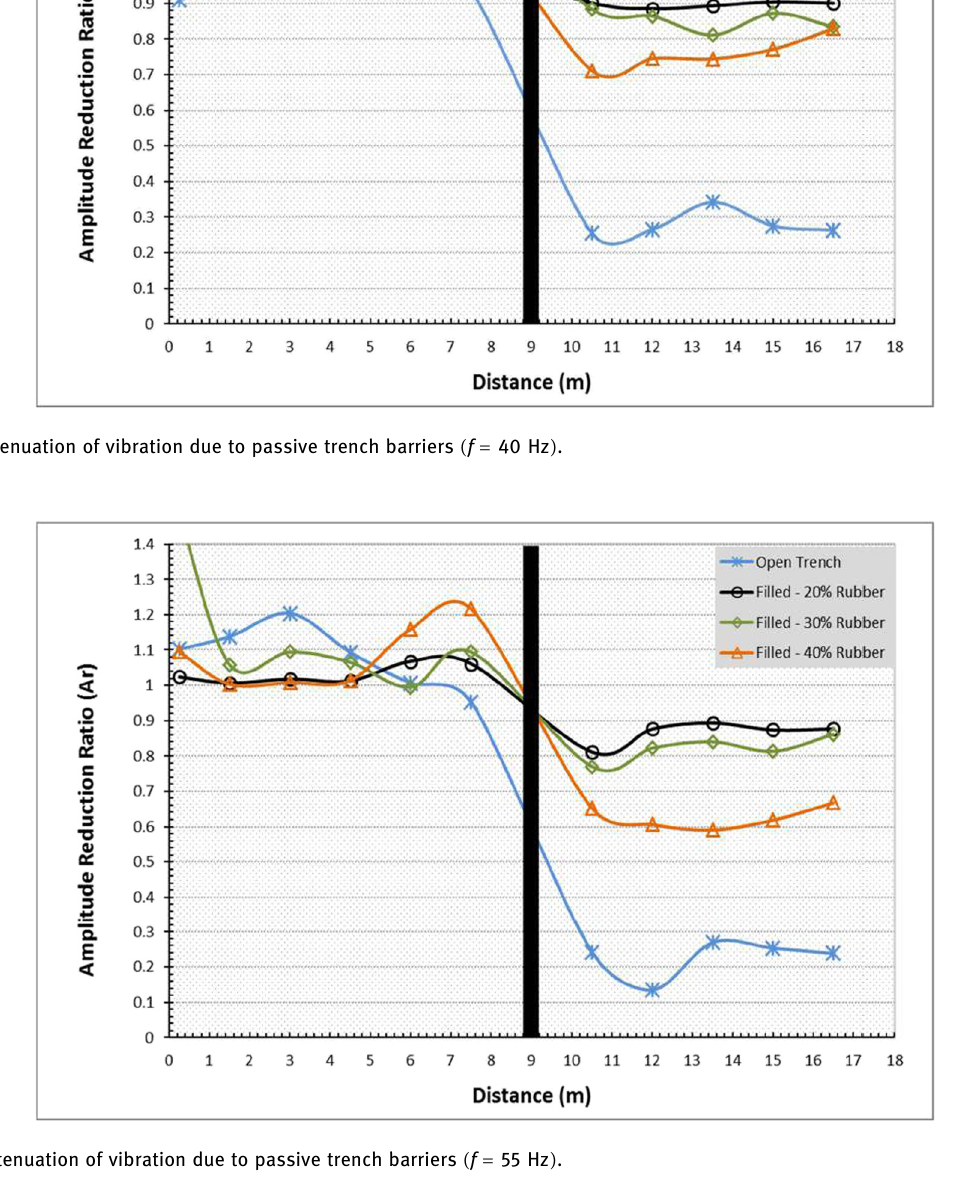
Figure 20: Attenuation of vibration due to passive trench barriers ( f 55 Hz = )